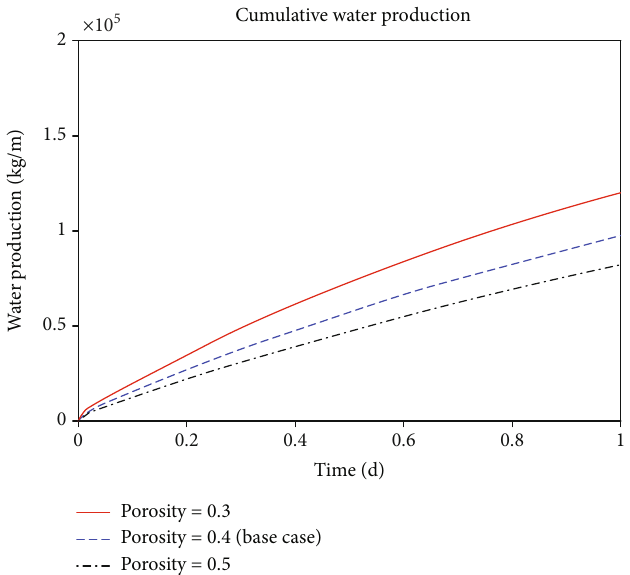
Figure 14: Cumulative water production at the wellbore during one day of shallow water fl ow for porosity sensitivity.